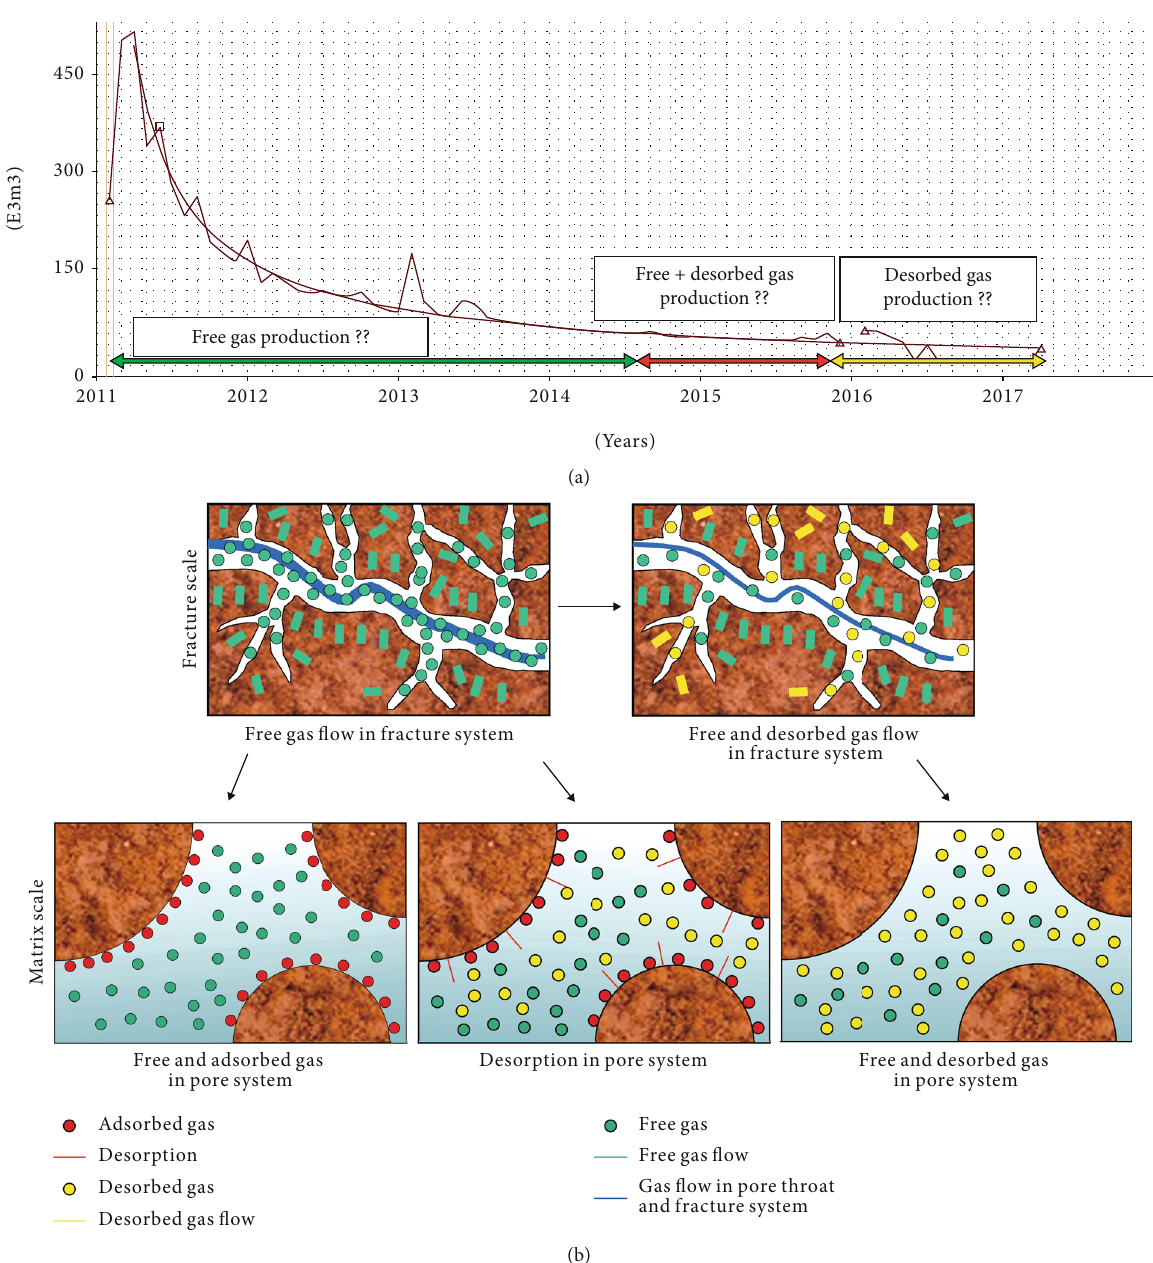
Figure 1: (a) Gas production pro fi le of well 200/C-045-K/94-O-05/2 in British Columbia, Canada. (b) The schematic diagram of free and desorbed gas transport mechanism in shale reservoir. E 3 m 3 : thousand cubic